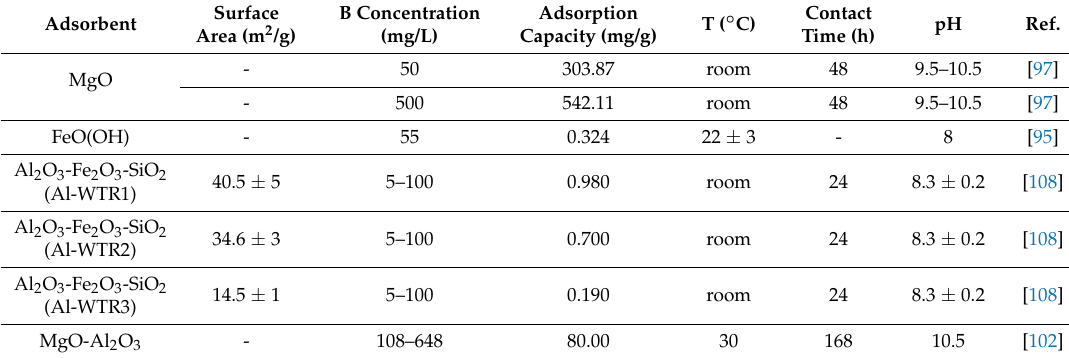
Table 4. Sorption properties of metal oxide-based adsorbents for boron oxyanions removal.